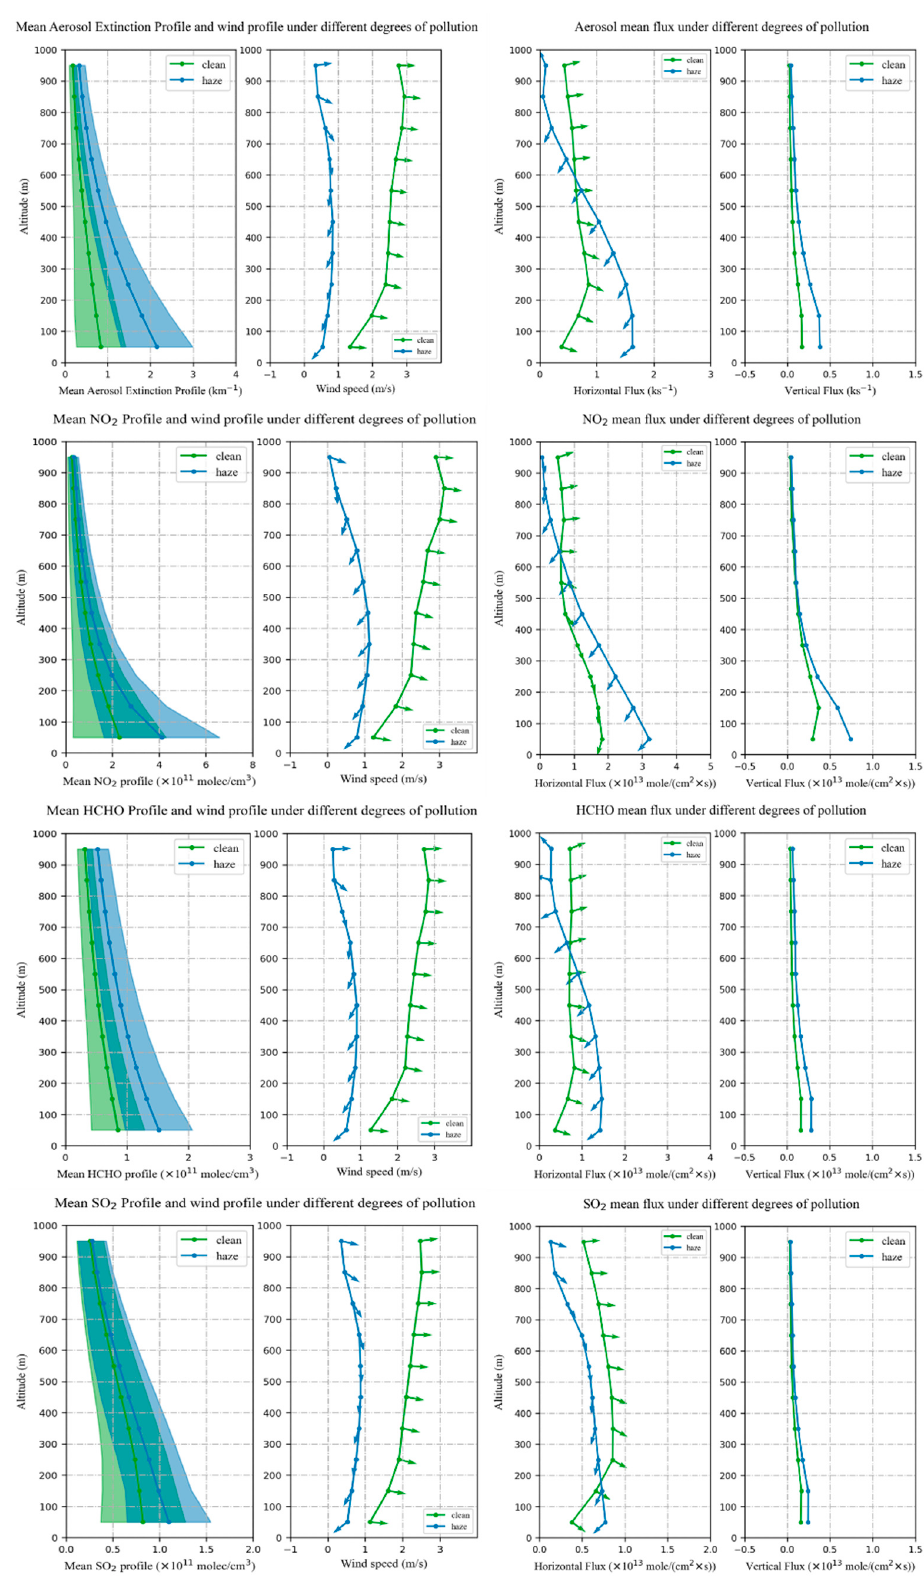
Figure A3. Mean pollutants profiles (first column), mean wind profiles (second column), mean horizontal transport flux profiles (third column) and mean vertical transport flux profiles (fourth column) during clear days and polluted days. Each row is the result of aerosol extinction, NO 2 , HCHO and SO 2 , respectively (from top to bottom).